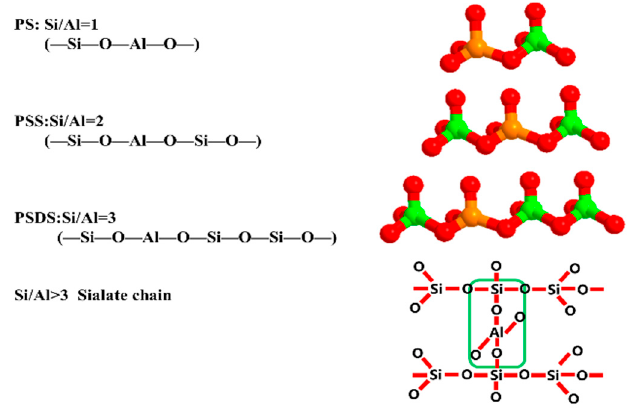
Figure 5. Geopolymer models with different Si/Al molar ratios.